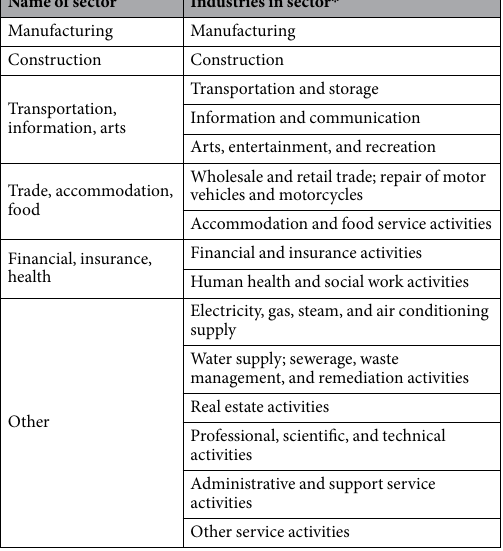
Table 2. Industries included in the analysis, by industry sector. * Based on the United Nations’ international standard industrial classification of all economic activities, rev. 4 14 . Industries lacking complete data were excluded from our analysis. These included: agriculture, forestry, and fishing; mining and quarrying; public administration and defense/compulsory social security; and